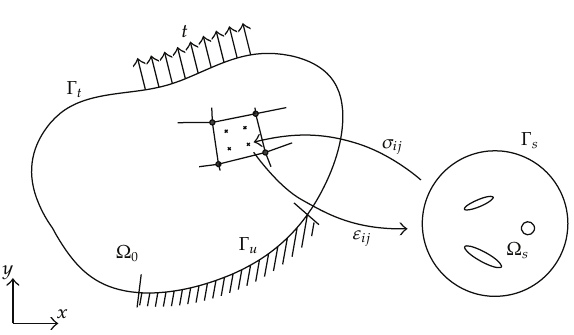
Figure 2: Schematic diagram of modeling in multiple